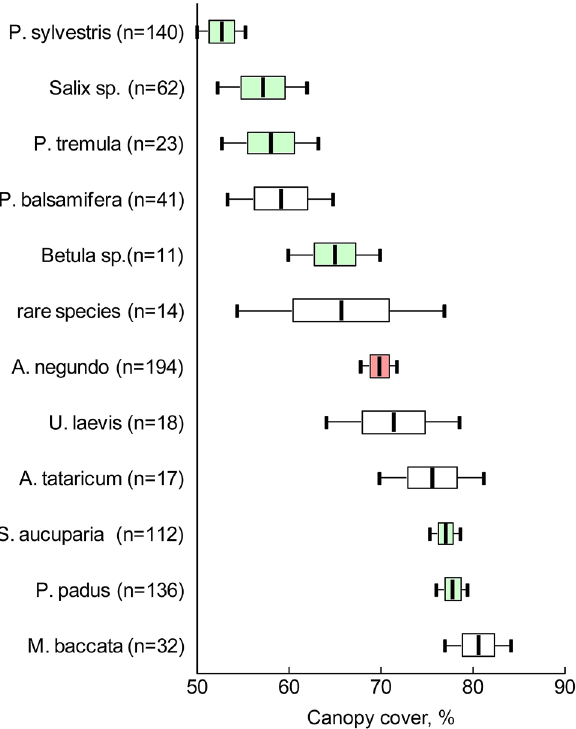
Figure 4. Average rates (± SE, ± 95CI) of canopy cover of different species of native (green plots) and alien (whitr and pink plots) tree species; rare species—the indication for a group of plots dominated by species rarely found in the studied site ( Amelanchier spicata , Caragana arborescens , Cotoneaster lucidus , Crataegus sanguinea , Larix sibirica , Lonicera xylostella , Tilia cordata ).